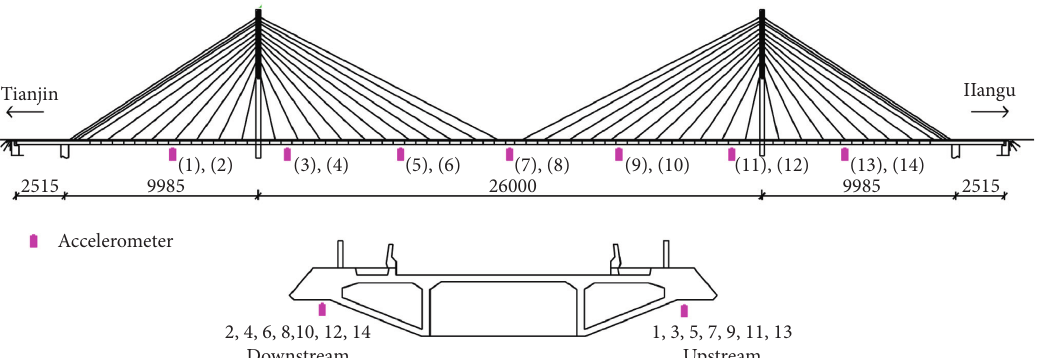
Figure 6: Elevation of the Tianjin Yonghe Bridge with the main dimensions and accelerations health monitoring system. Adapted from “Structural health monitoring of a cable-stayed bridge with Bayesian neural networks” by Stefania Arangio & Franco Bontempi (2015), Structure and Infrastructure Engineering, 11:4, 575–587, reprinted by permission of Taylor & Francis Ltd.